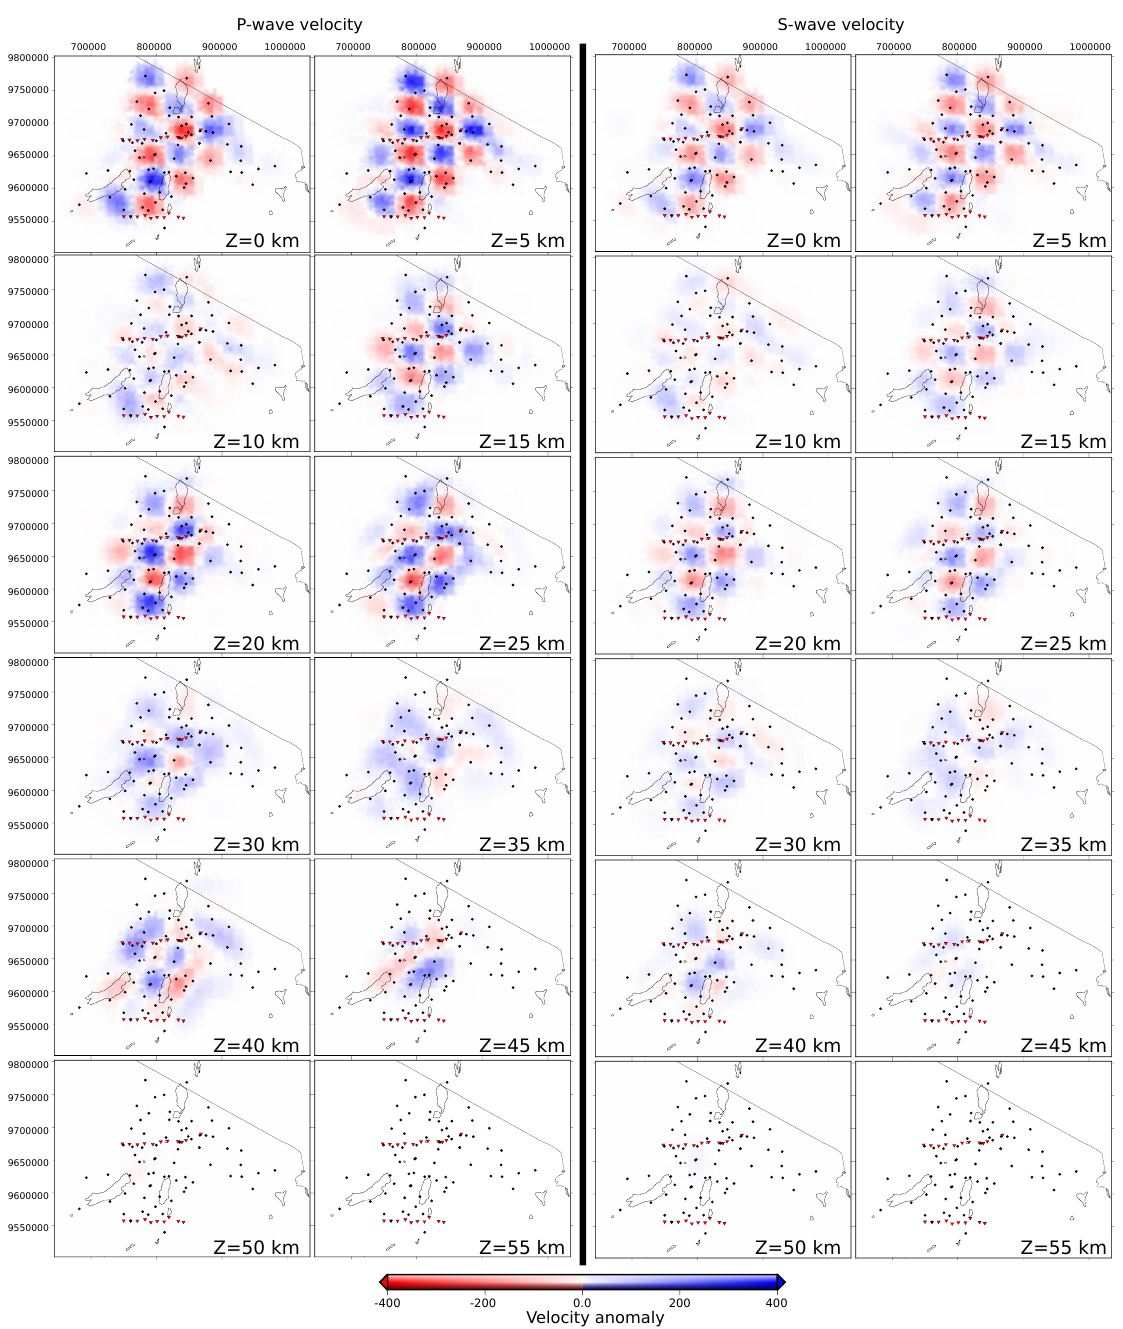
Figure A10. Results from checkerboard test for the tomography model. On the left results for the P-wave velocity model, on the right for the S-wave velocity. The white color indicates zones not constrained by seismic rays. See text for more